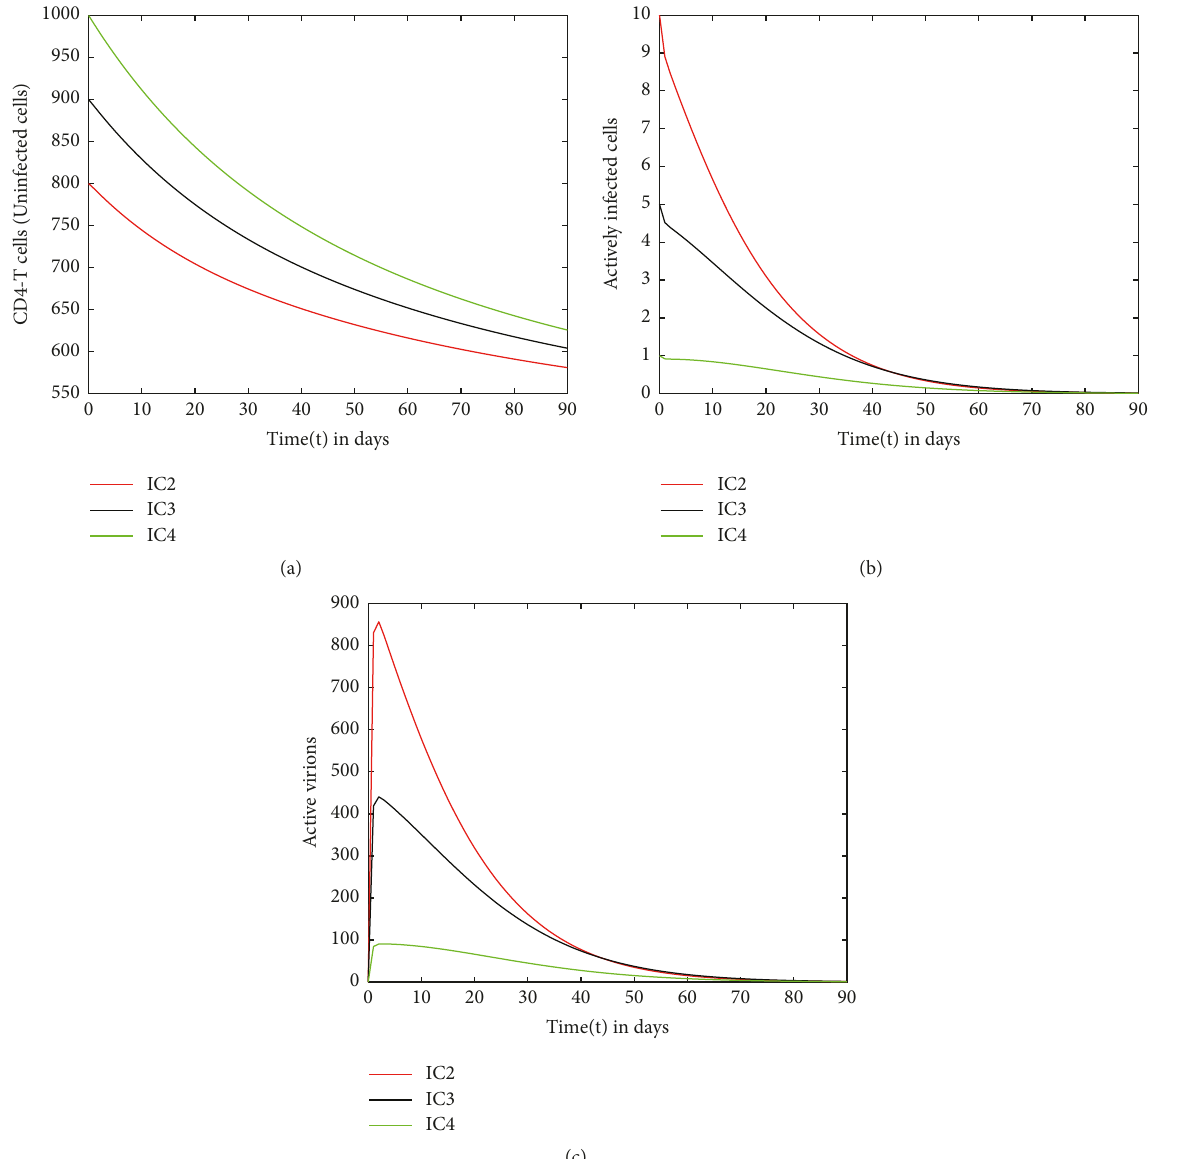
Figure 4: (a)-(c) The graph trajectory of 𝑇(𝑡) , 𝑇 ⋆ (𝑡) , and 𝑉(𝑡) for 𝜌 = 0.9 and 𝜗 = 0.9 with the initial conditions IC2-IC4. 𝑅 0 = 0.101 < 1 and 𝐸 = (1500,0,0) is globally asymptotically 0